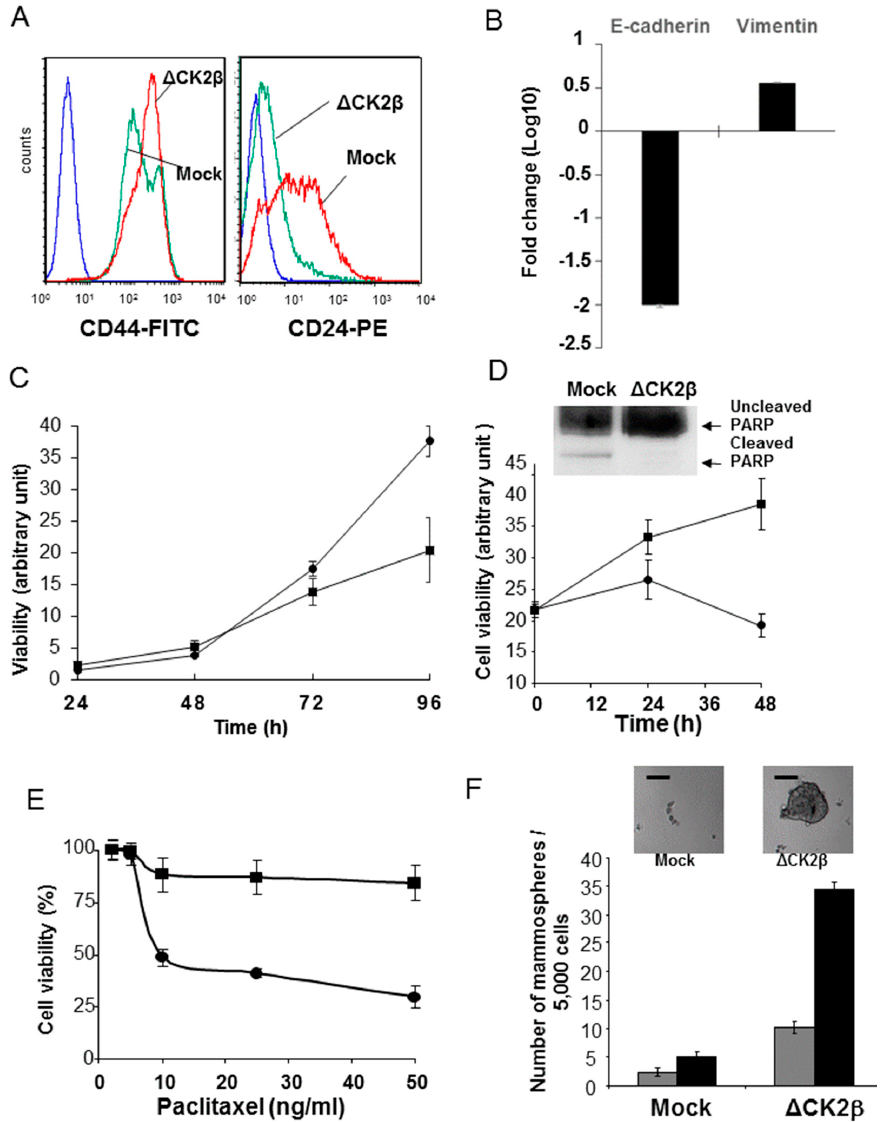
Figure 2. Δ CK2 β -MCF10A cells have properties of cancer stem cells (CSCs) and are drug resistant. Figure 2. ∆ CK2 β -MCF10A cells have properties of cancer stem cells(CSCs) and are drug resistant. ( A ) FACS analysis of CD24 and CD44 markers in in Mock- and Δ CK2 β -cells (Blue line, unlabelled ( A ) FACS analysis of CD24 and CD44 markers in in Mock- and ∆ CK2 β -cells (Blue line, cells; green line, Mock-cells; red line, Δ CK2 β -cells). Results are representative of three independent